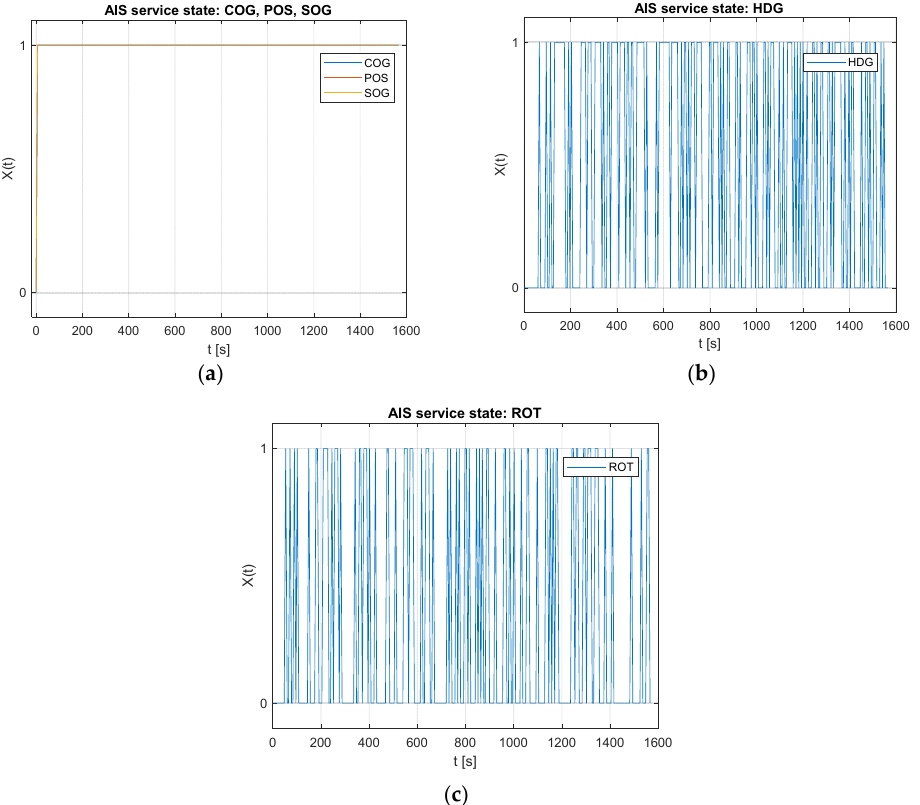
Figure 9. The AIS service state determined for p navigation parameters ( a ) COG, POS, SOG. ( b ) HDG. ( c ) ROT.